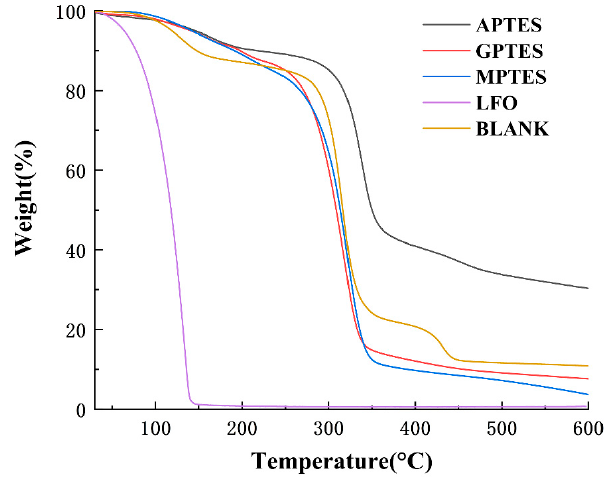
Figure 5. TGA curves of modified EC/SiO 2 fragrance microcapsules, LFO and EC fragrance micro- capsules (blank).